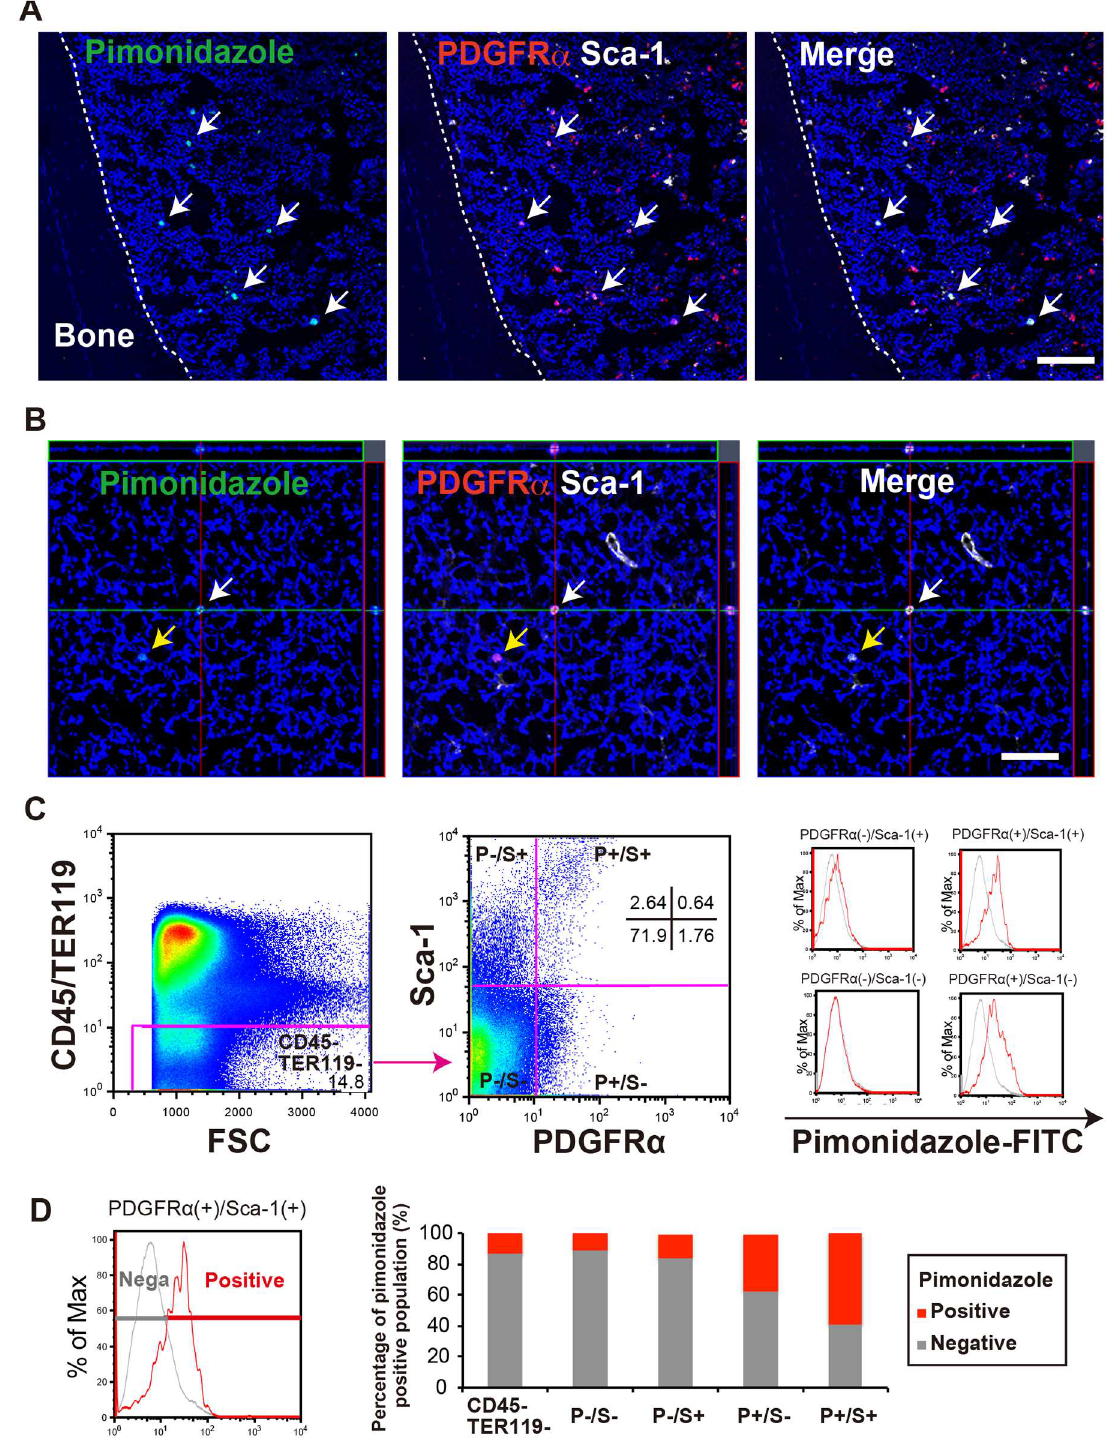
Fig 1. MSCs maintain a low oxidation level in the murine BM. (A) Representative IHC results for pimonidazole (green), PDGFR α (red), and Sca-1 (white), as well as Hoechst (blue) staining,in mouse BM. Scale bar = 100 μ m. White arrows indicate cells co-expressing pimonidazole, PDGFR α ,and Sca-1. (B) Confocalfluorescence microscopy(z-axis) images of pimonidazole-positive cells. Arrows indicatecells co-expressing the markers (white: pimonidazole high, PDGFR α , and Sca-1, yellow: pimonidazole low, PDGFR α , and Sca-1). Scale bars = 50 μ m. (C) Flow cytometric analysisof pimonidazole-stained cells in the BM compartment. BM cells were split into positive-pimonidazole (Red) and negative-pimonidazole (Gray) populations, with a negative control as an index. The hematopoietic lineagenegative(CD45 − TER119 − ) and PDGFR α /Sca-1